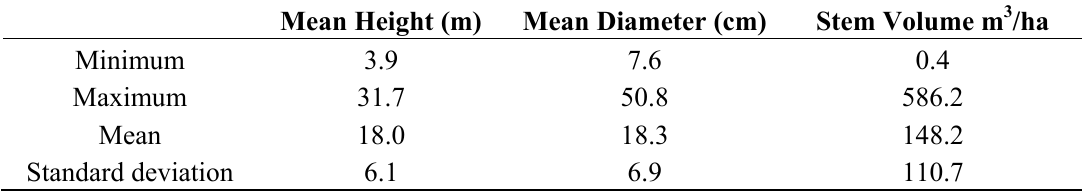
Table 1. Descriptive statistics of the field plots accessed in the